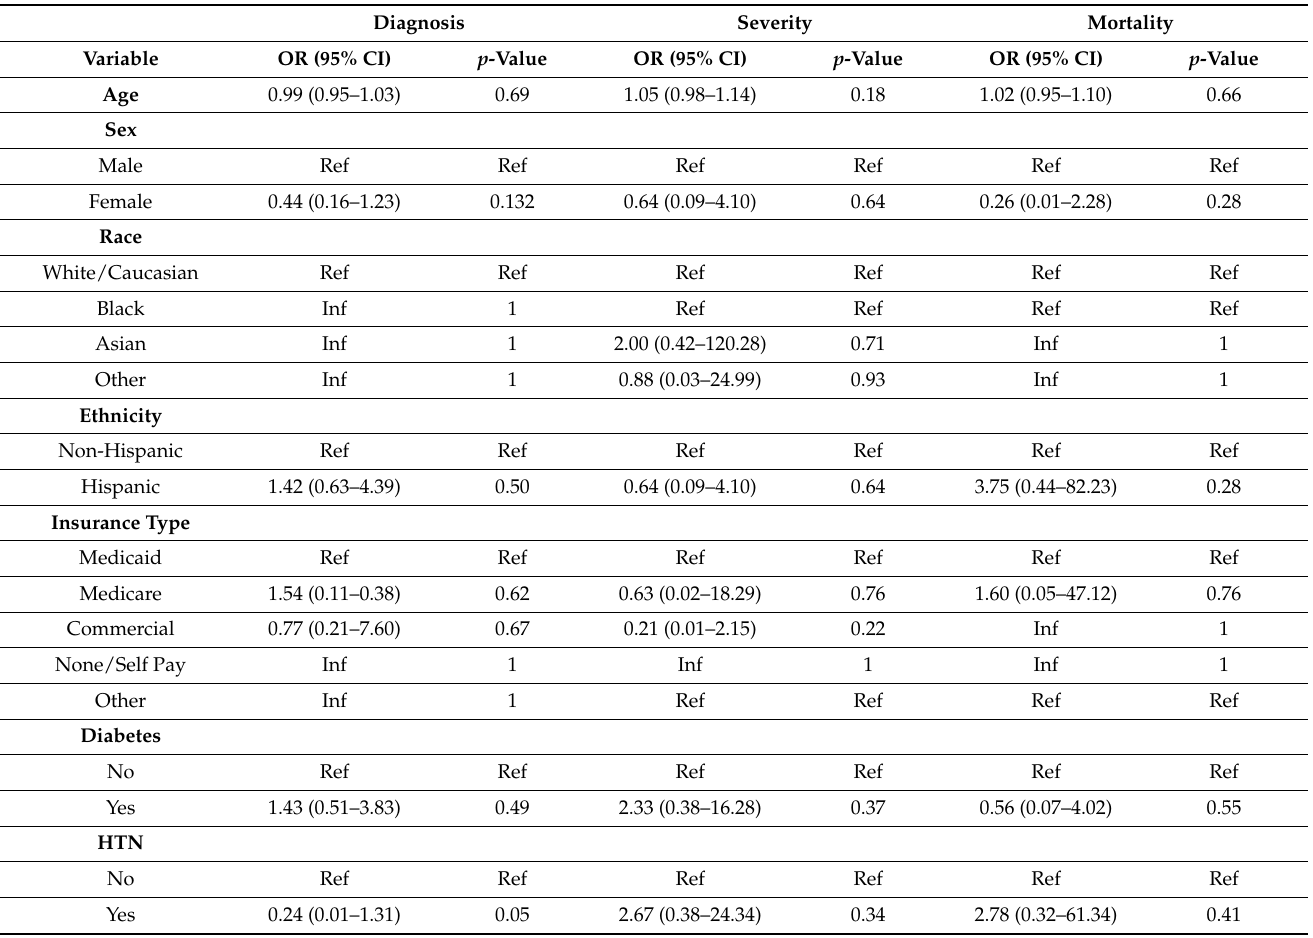
Table 3. Predictors of COVID diagnosis, severity, and